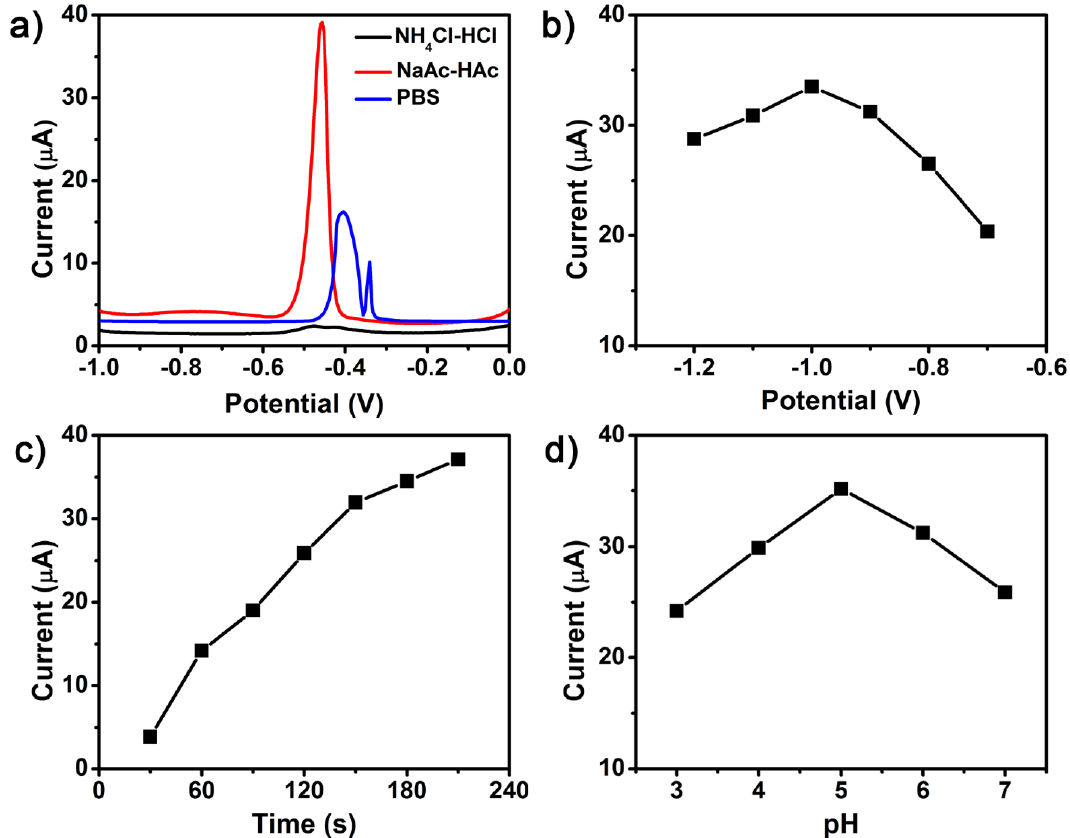
Figure 3. Influence of experimental parameters: ( a ) supporting electrolytes, ( b ) deposition potential, ( c ) deposition time and ( d ) pH values on Square wave anodic stripping voltammetry (SWASV) responses of the TiO 2 modified glass carbon electrode (GCE) in 0.1 M NaAc-HAc containing 0.5 μM Pb(II).